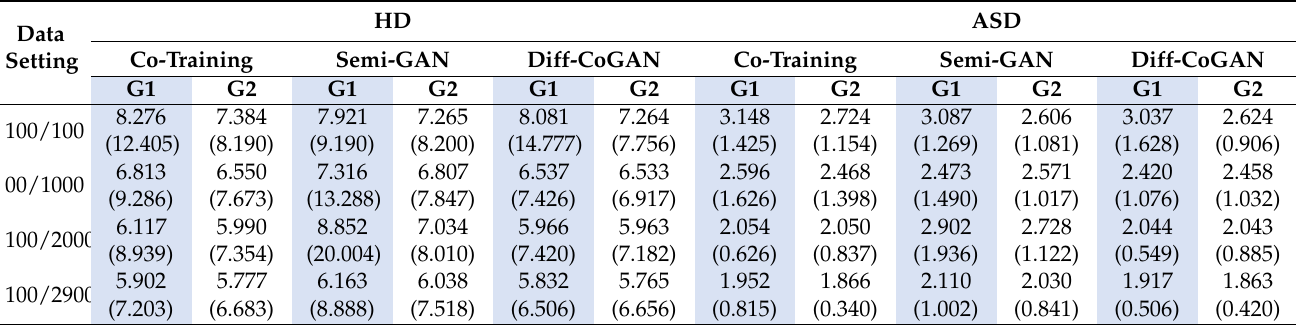
Table 5. The HD and ASD values using the Hippocampus dataset show that Diff-CoGAN performs better than co-training and semi-GAN when processing boundaries during segmentation.